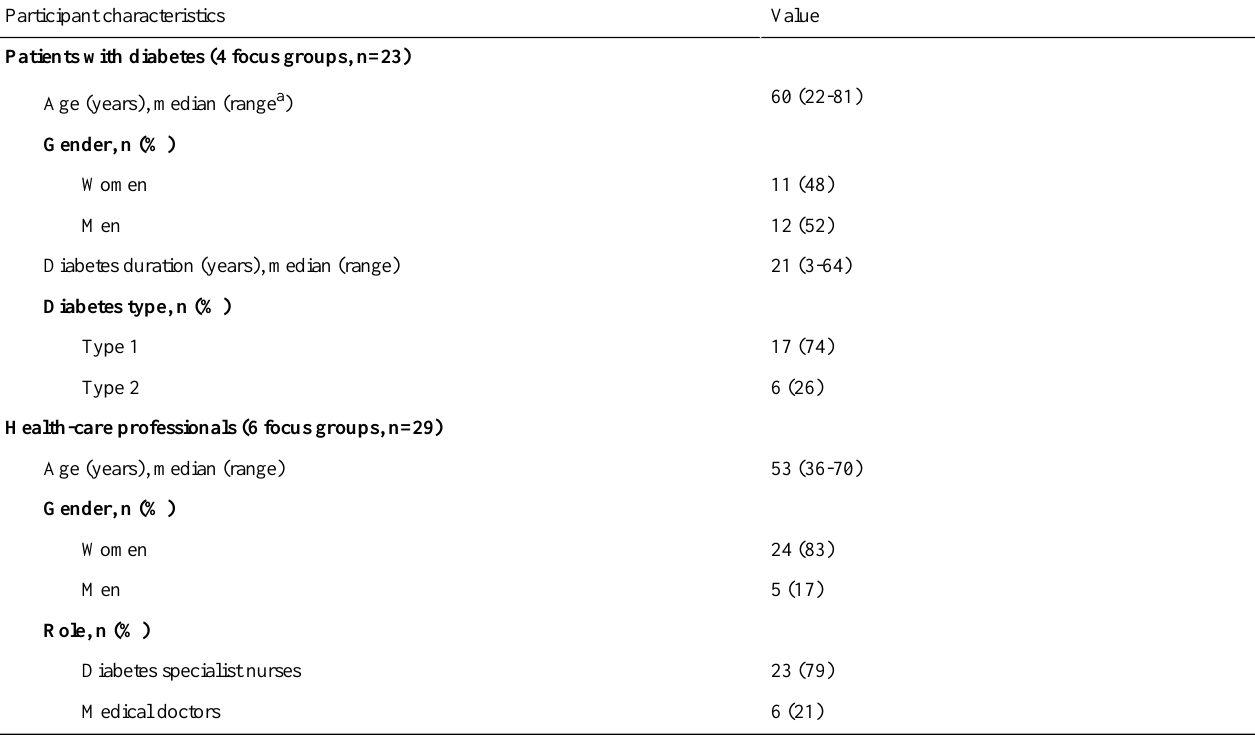
Table 1. Focus group participant